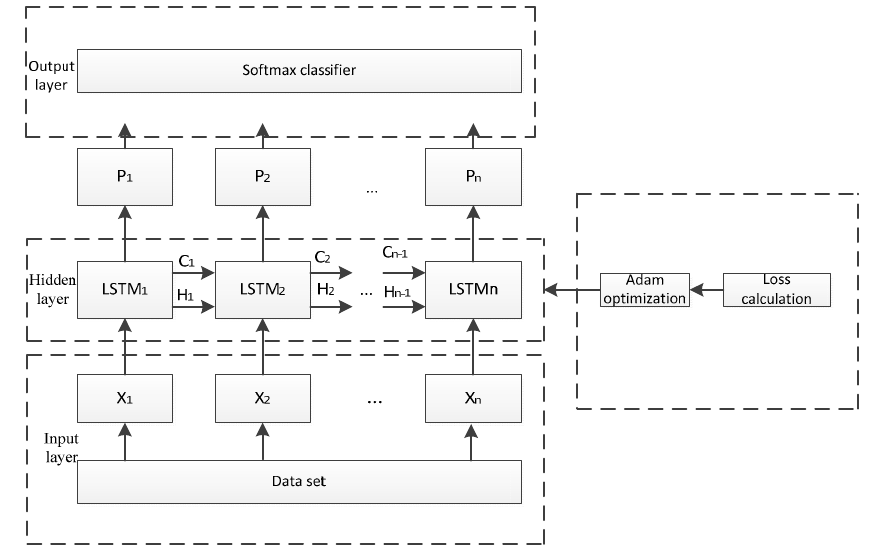
Figure 6. The Framework of The LSTM Time Series.